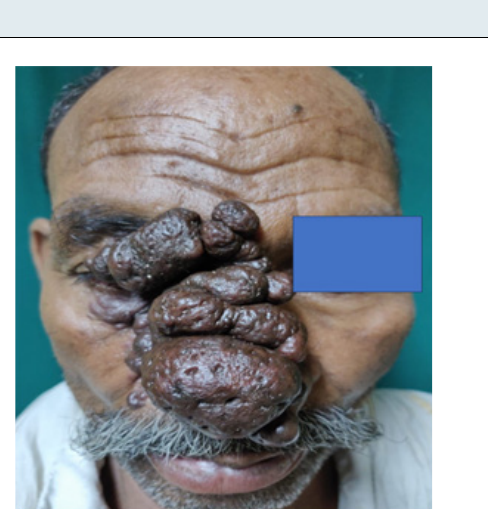
Figure 1: non-blanching reddish plaques with nodularity, firm on palpation of size 7x2x3 cm. ( Permission was obtained for publication of the image